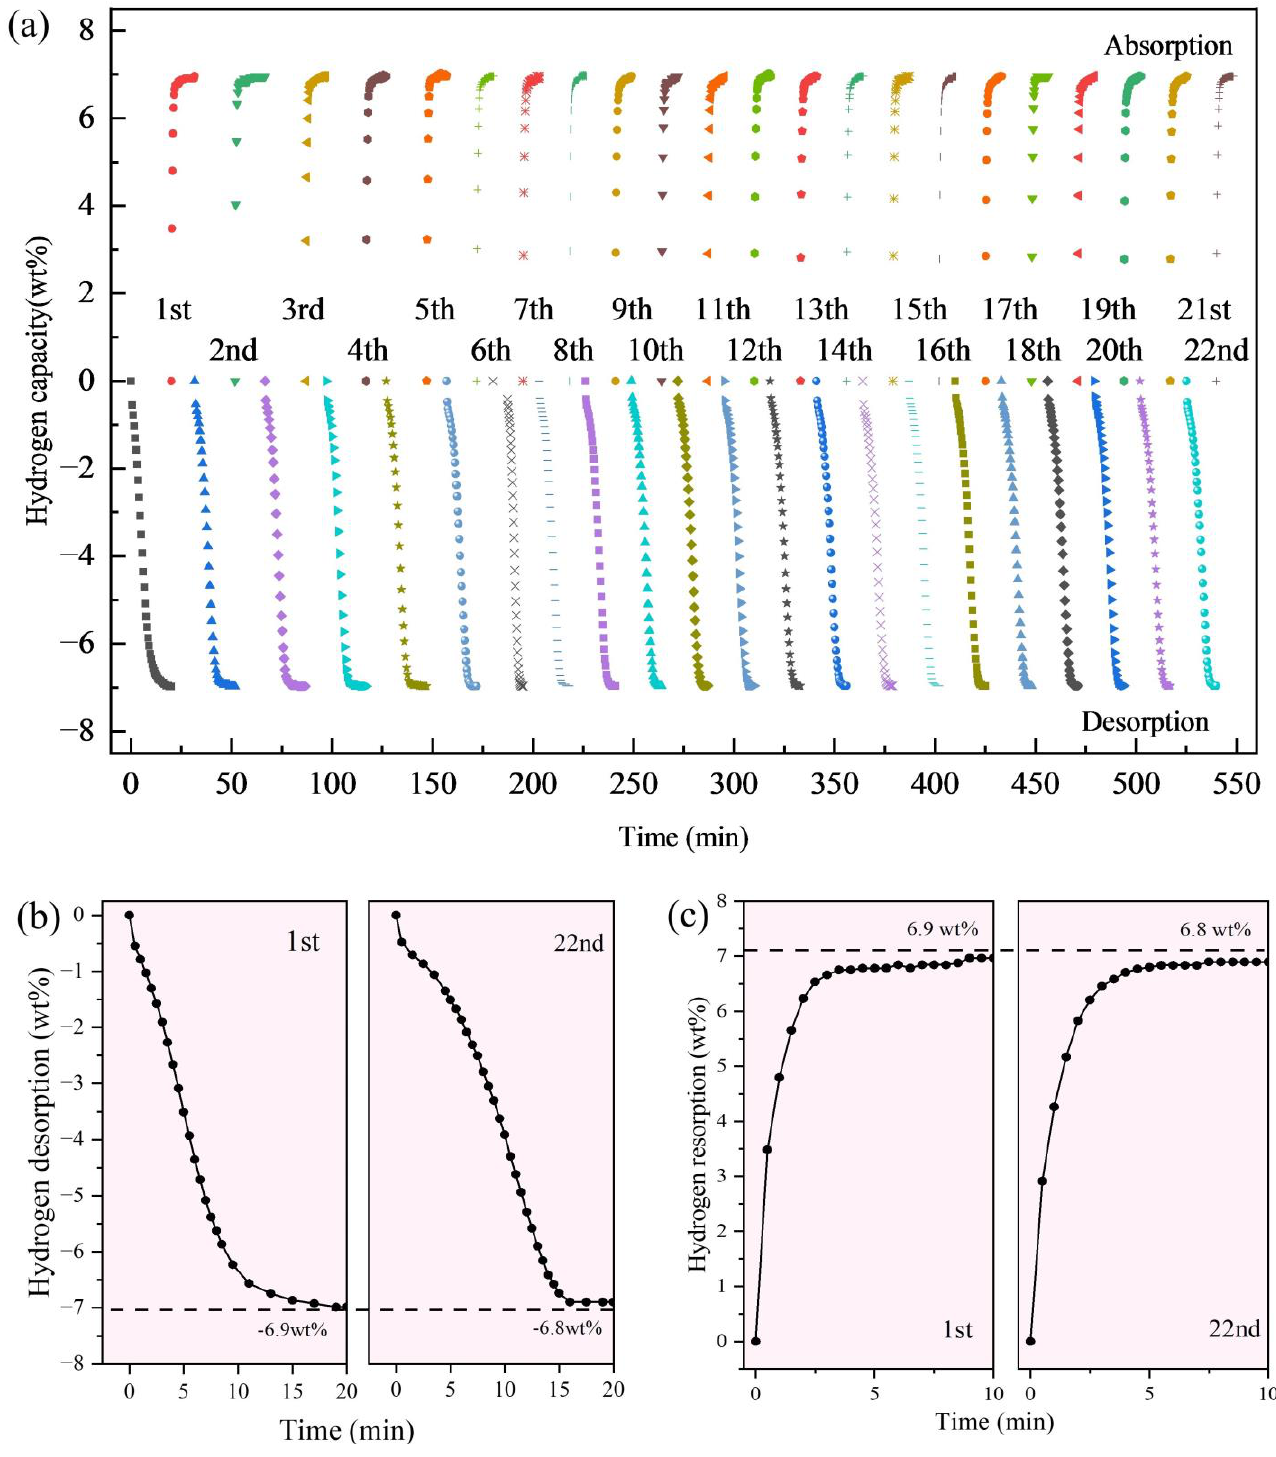
Figure 5. ( a ) Kinetic curves of isothermal hydrogenation (at 30 bar H 2 ) and dehydrogenation cycles of MgH 2 -7wt%Mo composite from the 1st to the 22nd cycle at 350 ◦ C; ( b ) the 1st and 22nd isothermal dehydrogenation curves of the composite at 350 ◦ C; and ( c ) the 1st and 22nd isothermal hydrogen absorption curves of the composite at 350 ◦